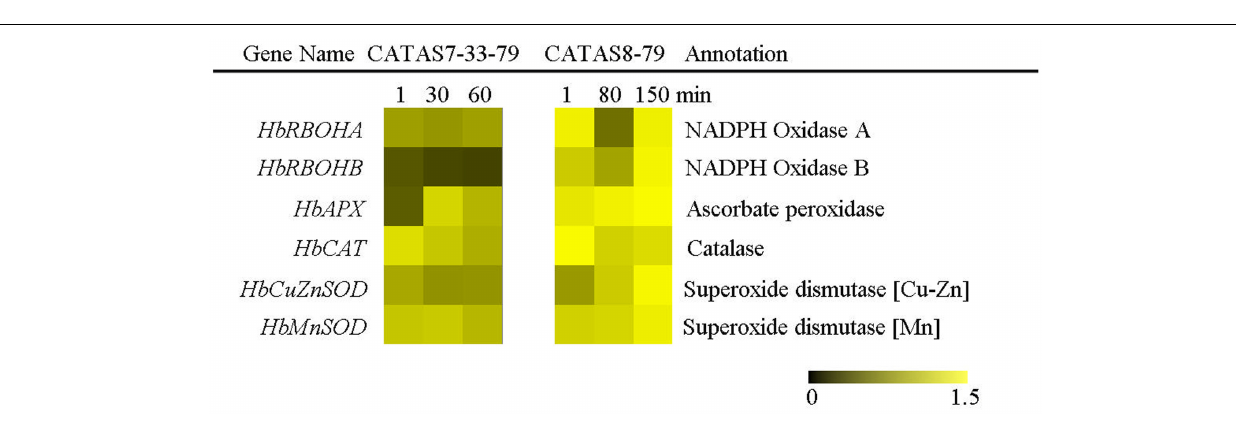
FIGURE 6 | The qRT-PCR analysis of ROS generation and scavenging system related genes across three stages of latex flow between CATAS7-33-97 and